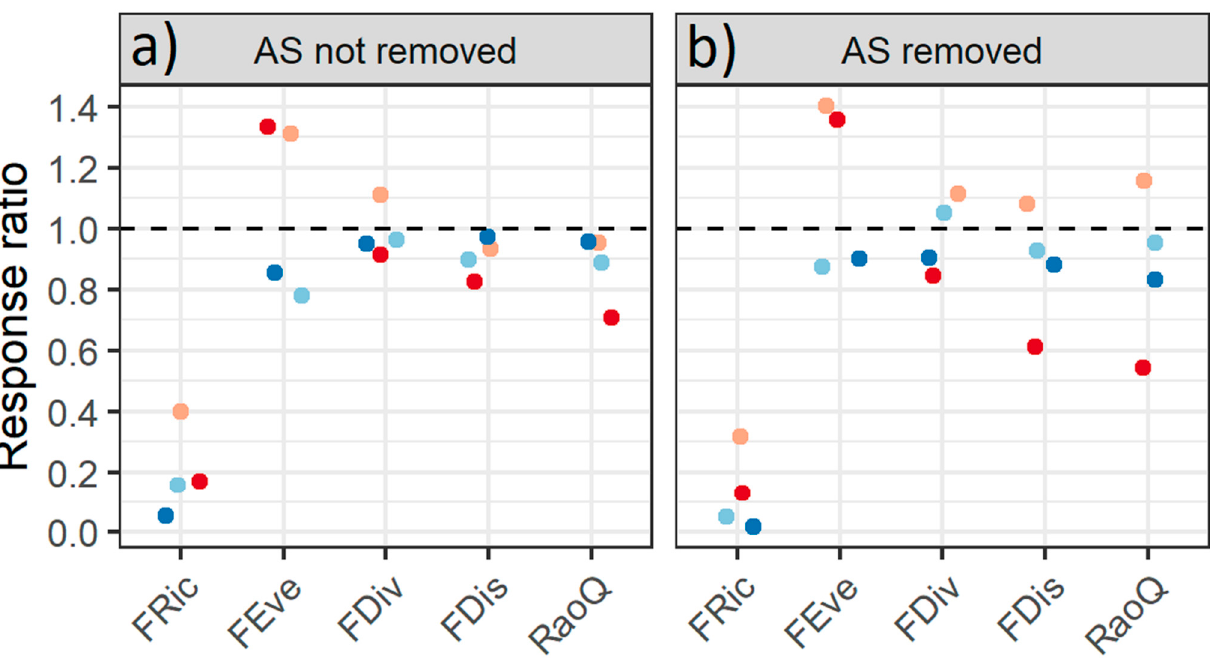
Figure 5. Response ratio between the functional diversity indices (FRic, FEve, FDiv, FDis and RaoQ) of the invaded communities (numerator) and not-invaded communities (denominator) in two scenarios: ( a ) Alien species (AS) not removed and ( b ) AS removed on marine tropical rocky shores along the coast of the State of Rio de Janeiro, Brazil at Praia Vermelha (red), Praia da Baleia (orange); Ilha de Âncora (light blue) and Ilha Comprida (dark blue).